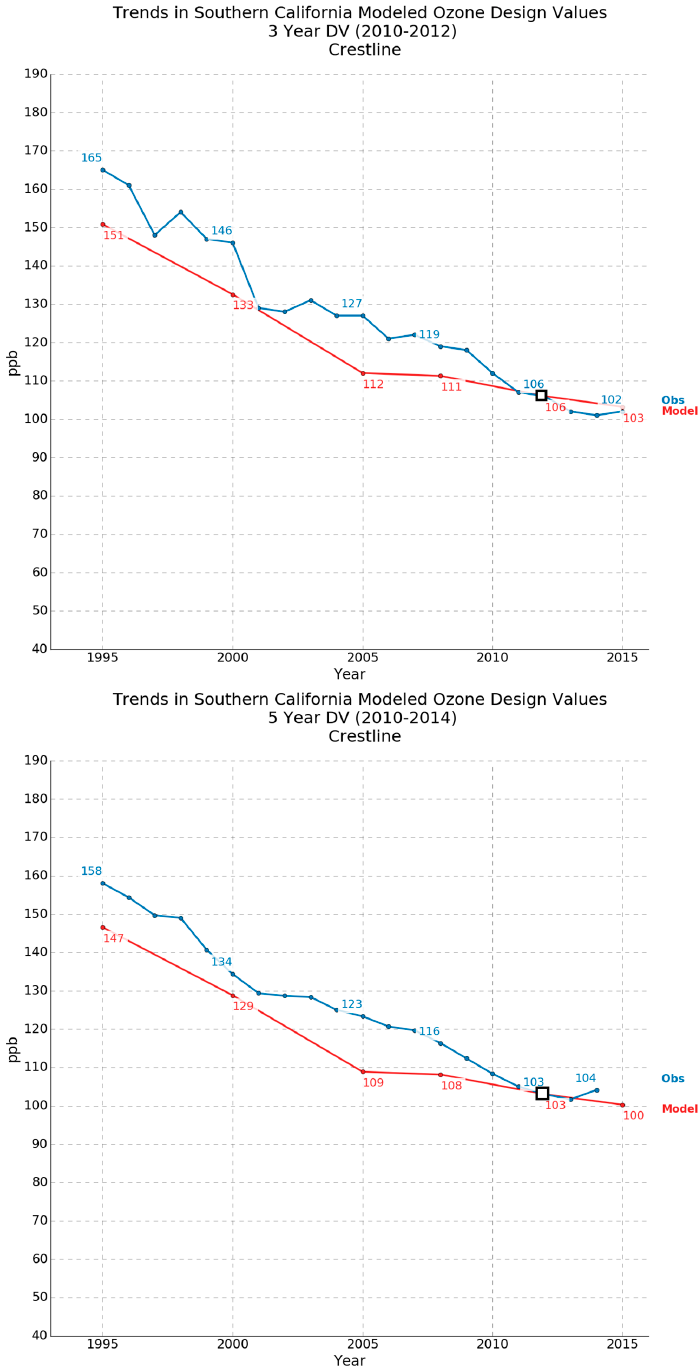
Figure 7. Modeled and observed trends in 3-year ( top ) and 5-year ( bottom ) design values at the Crestline monitor from 1995 to 2015 using the 2016 AQMP modeling database. The anchor (baseline) year for the design value calculations is 2012 (marked by the square symbol in the figures).